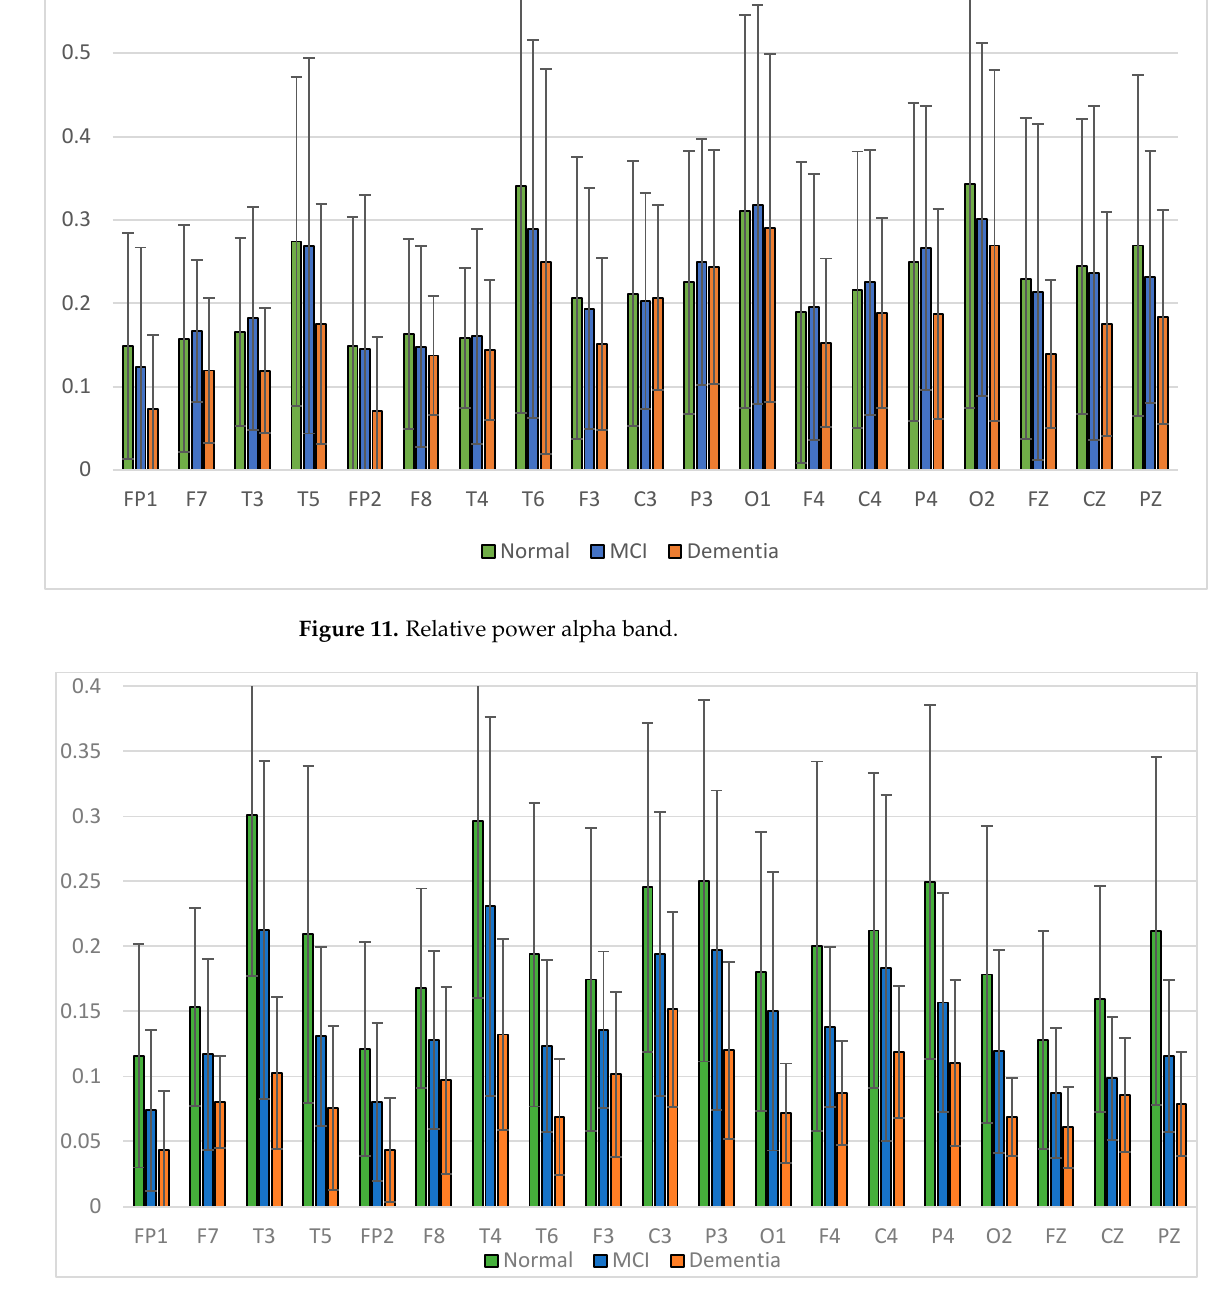
Figure 12. Relative power beta band.